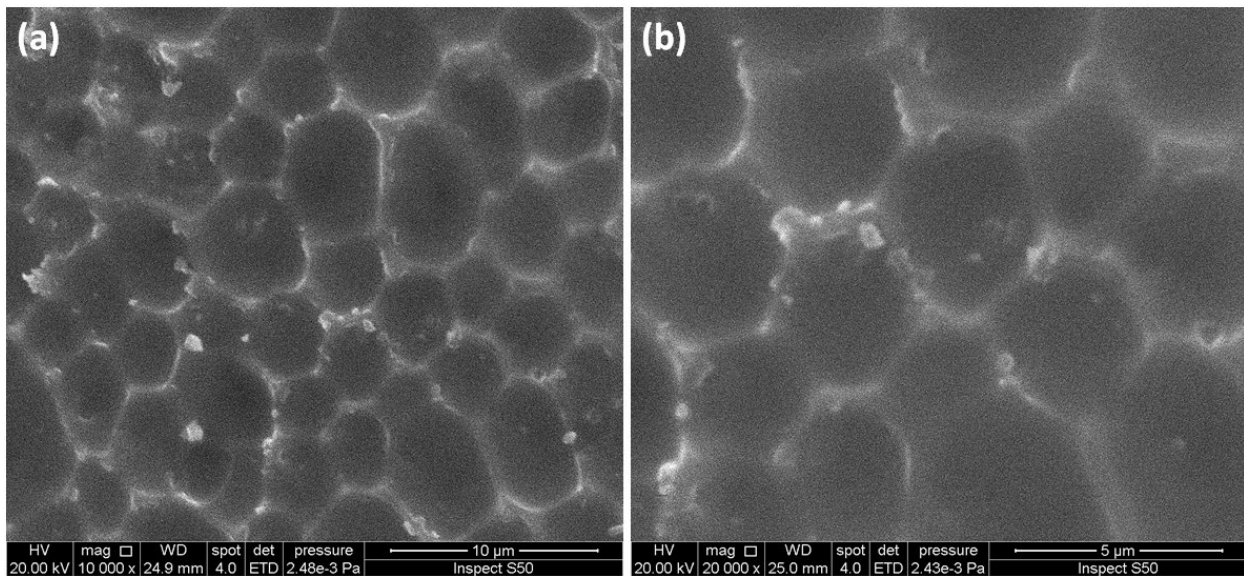
Figure 10. SEM images of PVC + 4 at: ( a ) 10 µm and ( b ) 5